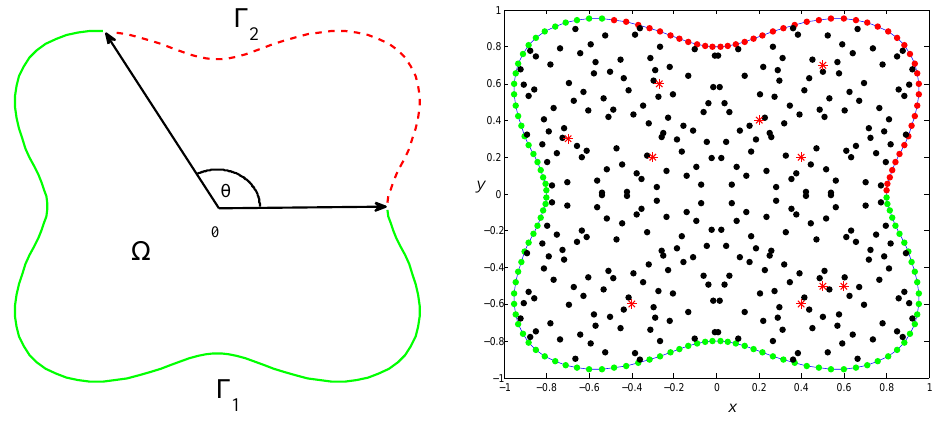
Figure 4. Model domain for test problem